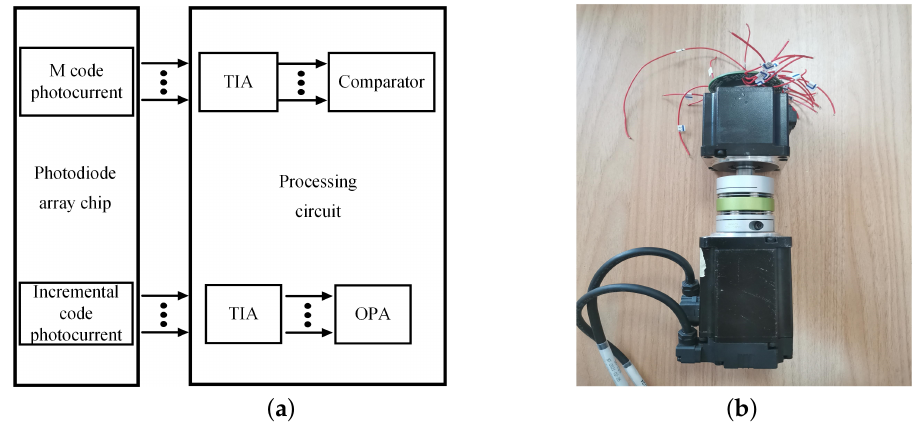
Figure 7. ( a ) Schematic diagram of test circuit. ( b ) Photo of test system.